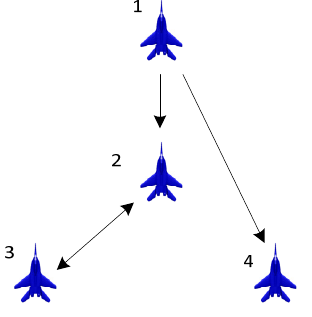
Figure 5. Communication topology for four fighters.